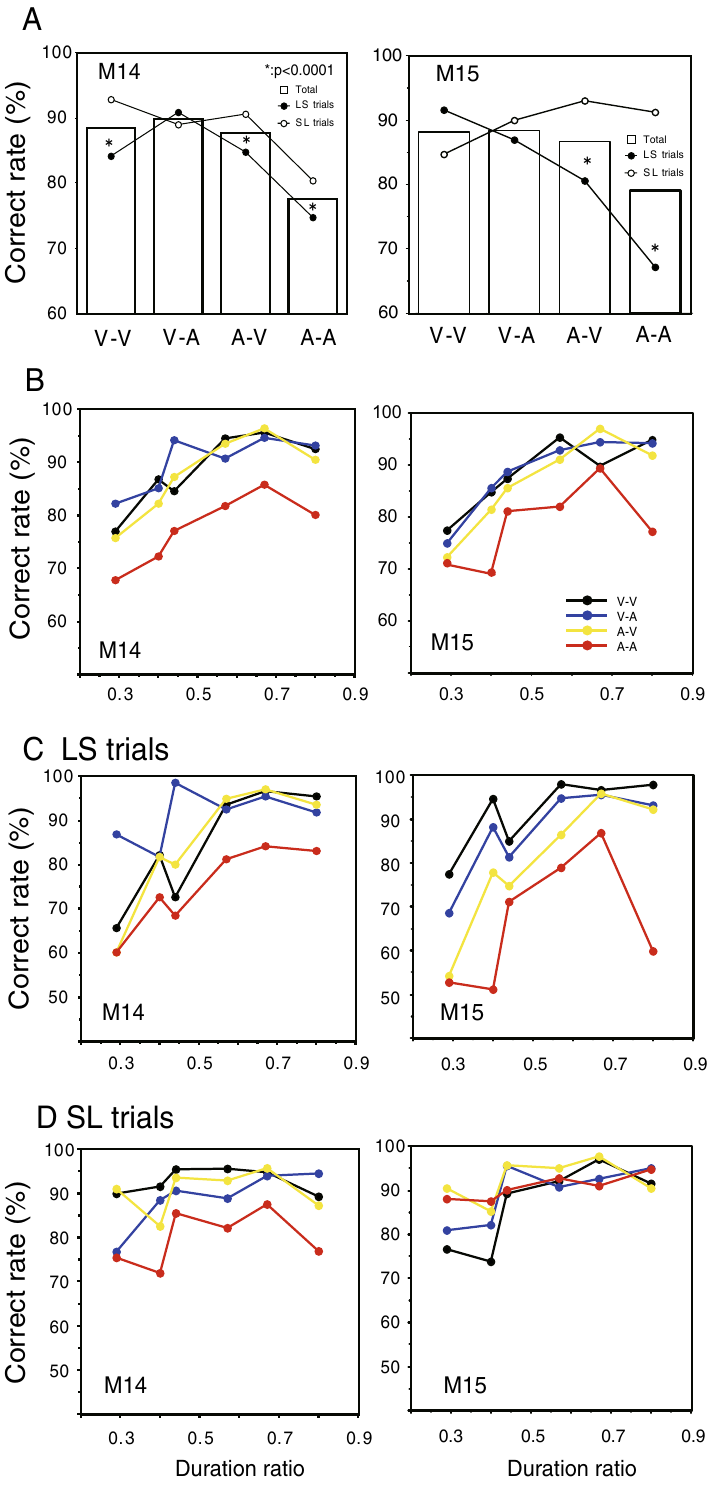
Figure 2. Correct rates for M14 (left column) and M15 (right column). ( A ) Correct response rates with the four cue modality sequences. Bar graphs show correct rates for each type of modality sequence. Line graphs show correct rates to the four modality sequences in the LS (long-short, black circle) and the SL (short-long, white circle) trials separately. Significant differences in correct rates between the LS and the SL trials are shown by asterisks ( p < 0.0001). ( B ) Correct rates as a function of duration ratios. Correct rates are plotted against duration ratios using the same color symbols for each type of modality sequence. ( C , D ) Correct response rates as a function of duration ratios separately shown for the LS ( C ) and the SL ( D )